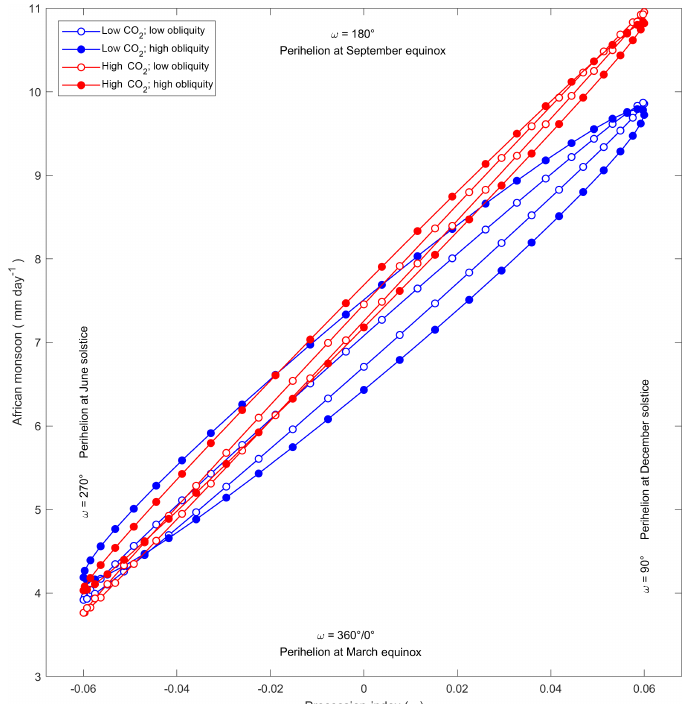
Figure 13. Emulated values of the African monsoon index, for the full range of the precession index ( e sin ω ), at low and high values of CO 2 and obliquity ( ε